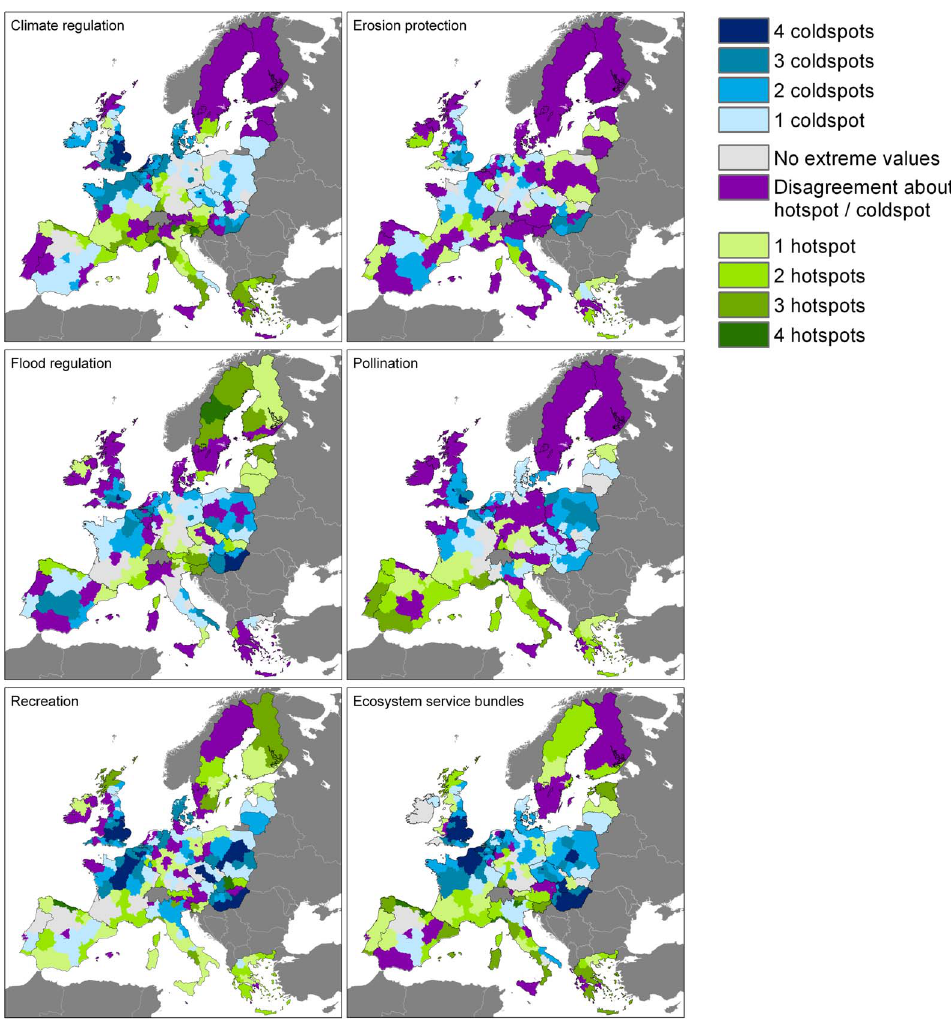
Figure 2. Agreement between maps for each ecosystem service. The maps indicate the number of maps that have a hotspot or coldspot per NUTS2 region. Dark grey areas were not